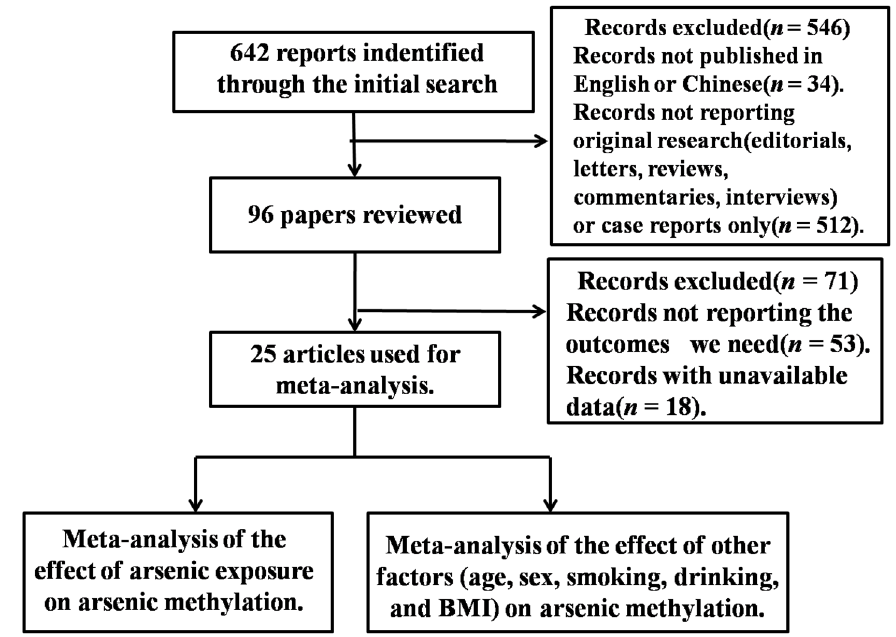
Figure 1. Flowchart of search strategy. BMI: body mass index